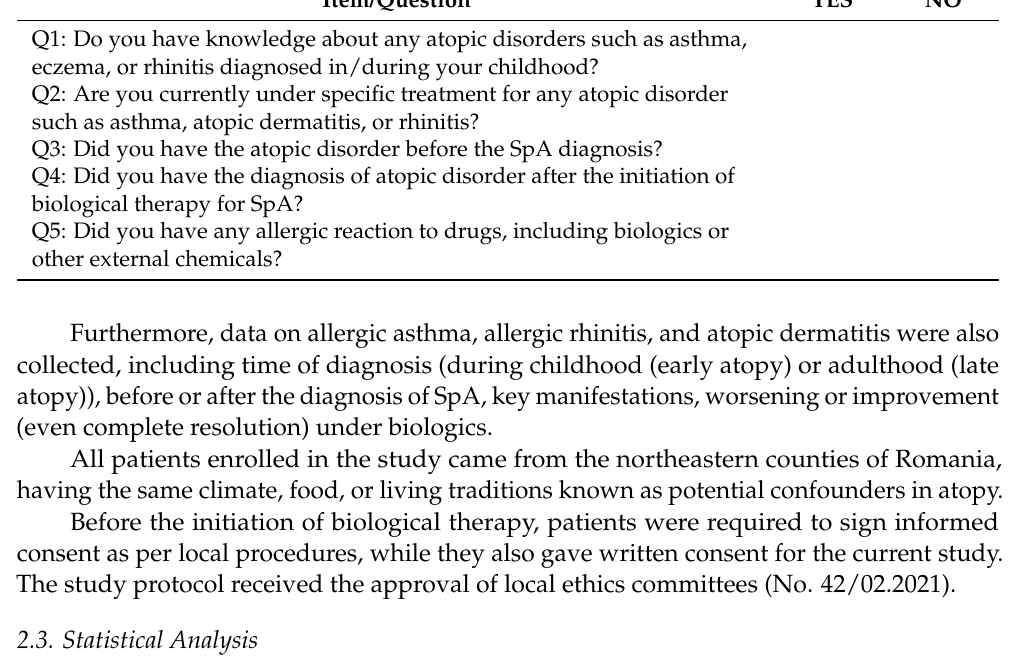
Table 1. The screening 5Q questionnaire applied in patients with spondyloarthropathies. Item/Question YES